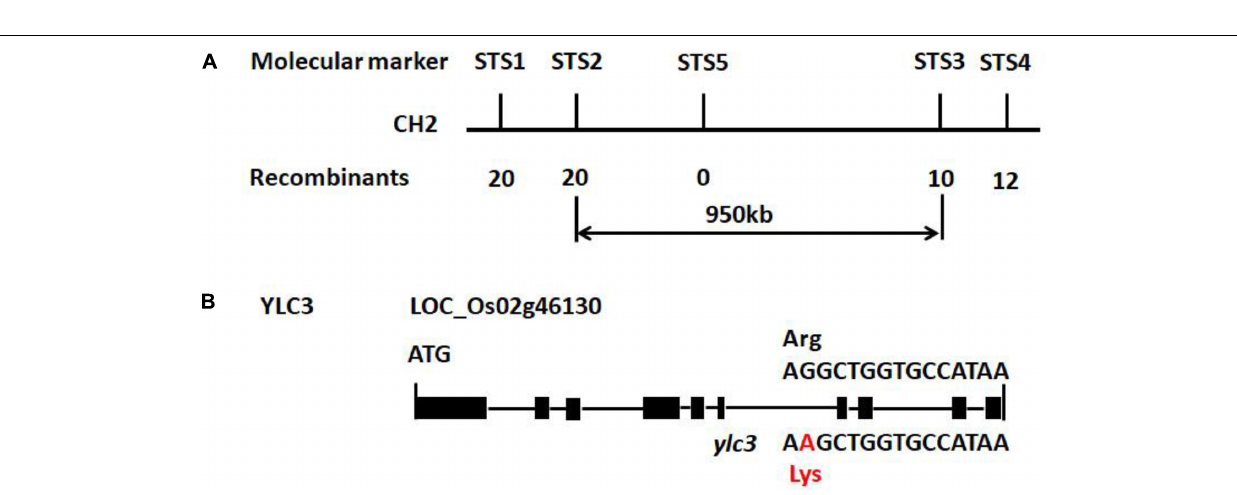
FIGURE 3 | Preliminary gene mapping and ylc3 mutation. (A) InDel markers (STS1-5) used for preliminary mapping are indicated. Numbers of recombinants and F 2 mutants (n) are shown. (B) Gene structure of YLC3 and the mutation site. The “A” in red indicates a one base-pair substitution in ylc3 . Black rectangles represent